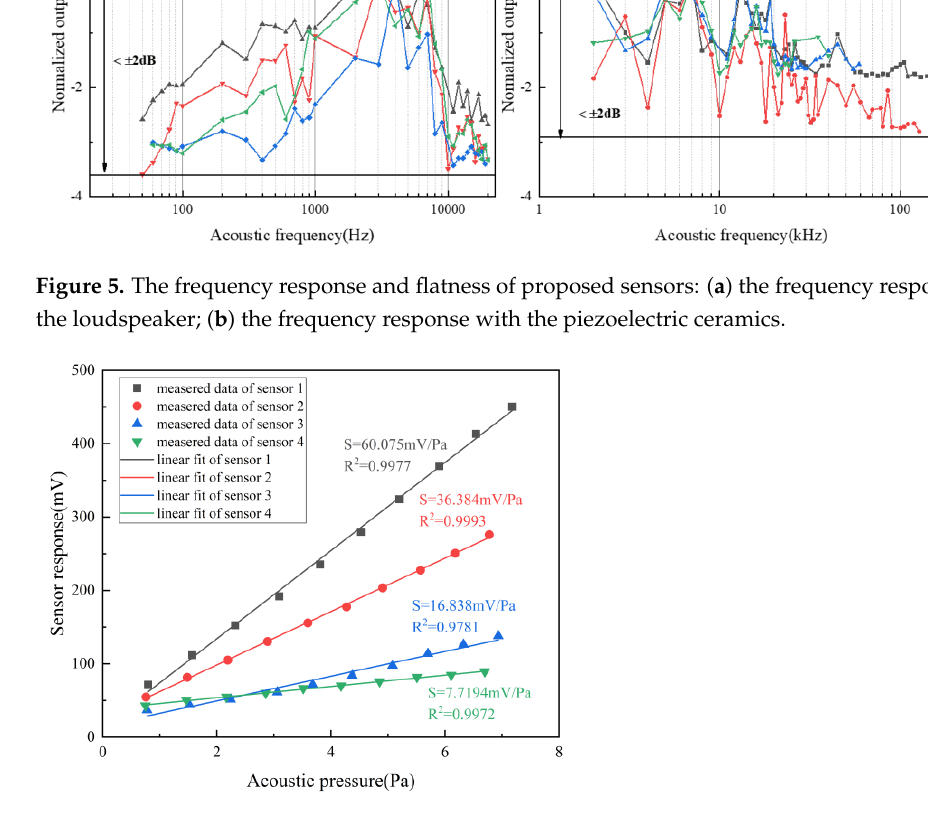
Figure 6. Comparison of the sensitivity of proposed acoustic sensors.